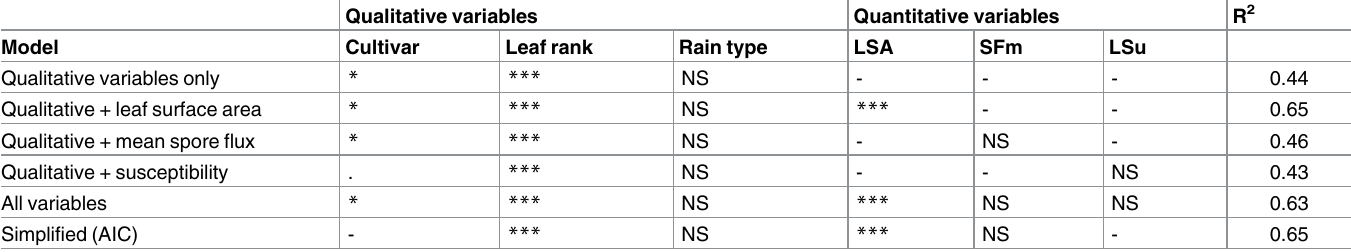
Table 3. Analysis of varianceof disease total lesion area (cm 2 ) at row scale resulting from single splash-dispersal events in canopies differing in their architecture and cultivar